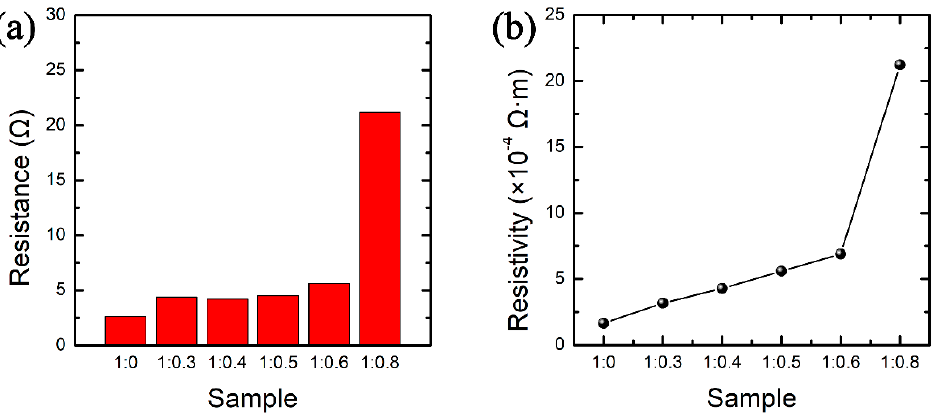
Figure 3. Comparison of ( a ) initial resistance and ( b ) resistivity of PDMS-Ag electrodes with different mass